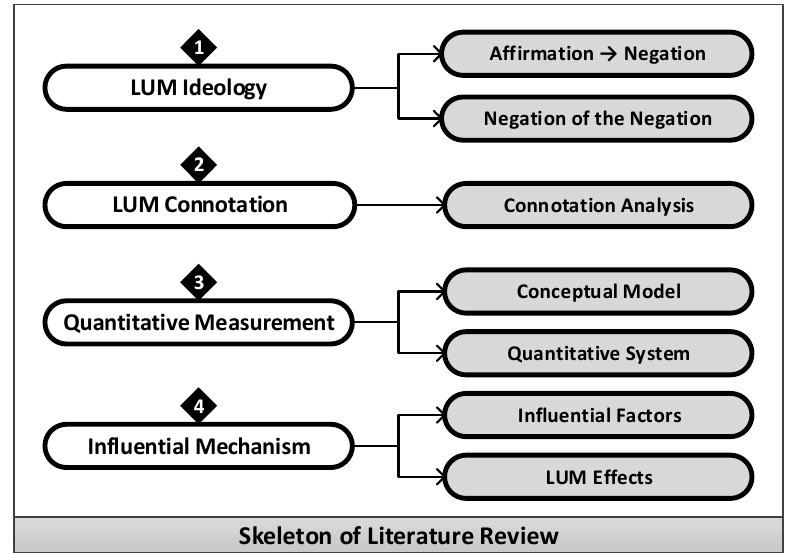
Figure 1. Skeleton of the literature review.